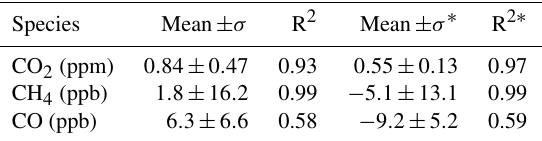
Table 5. Comparison of CO 2 , CH 4 and CO mole fractions between AirCore and LISA measurements. The difference is calculated as LISA minus AirCore. The correlation coefficient between LISA and averaged AirCore is also